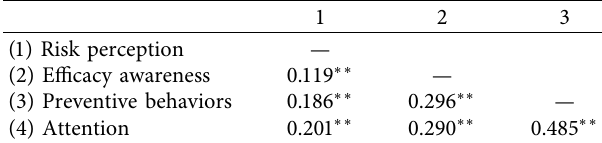
Table 7: Relationship between the audience’s attention to COVID-19 vaccine-related information and their COVID-19 risk perception, vaccine efcacy awareness, and preventive